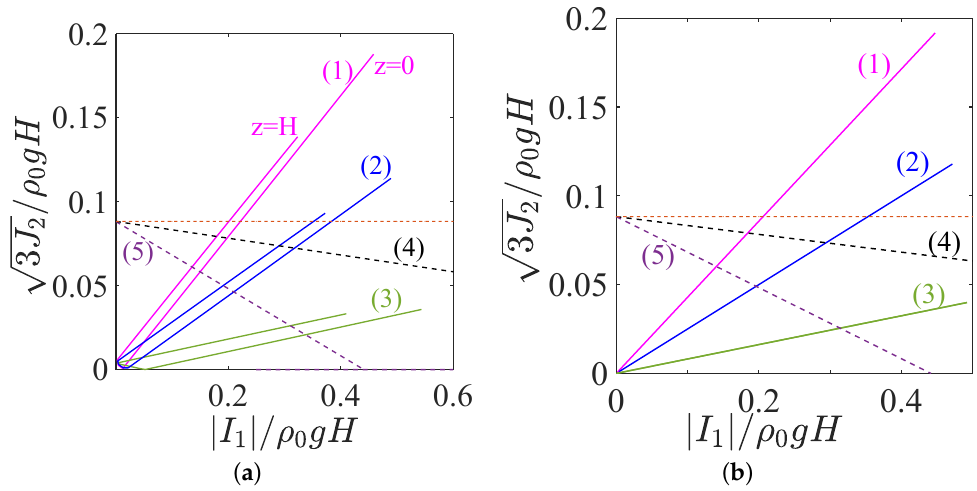
(cid:0) √ (cid:1) Figure 6. Values of the couple 3 J 2 / ρ 0 gH , | I 1 | / ρ 0 gH at different vertical positions and for different triplets ( κ , Λ , Ψ ) . ( a ) (1): ( 0.0204, 1.092, 0.849 ) , (2): ( 0.0340, 1.652, 1.416 ) , and (3): ( 0.102, 4.477, 4.247 ) . ( b ) The same parameters Λ and Ψ as in ( a ) with κ = 0. (4): (dashed line) Drucker–Prager criterion for A = 0.05, and (5): (dashed line) Drucker–Prager criterion for A = 0.2. √ The horizontal dashed line ( A = 0) is the von Mises yield criterion with σ y = 10